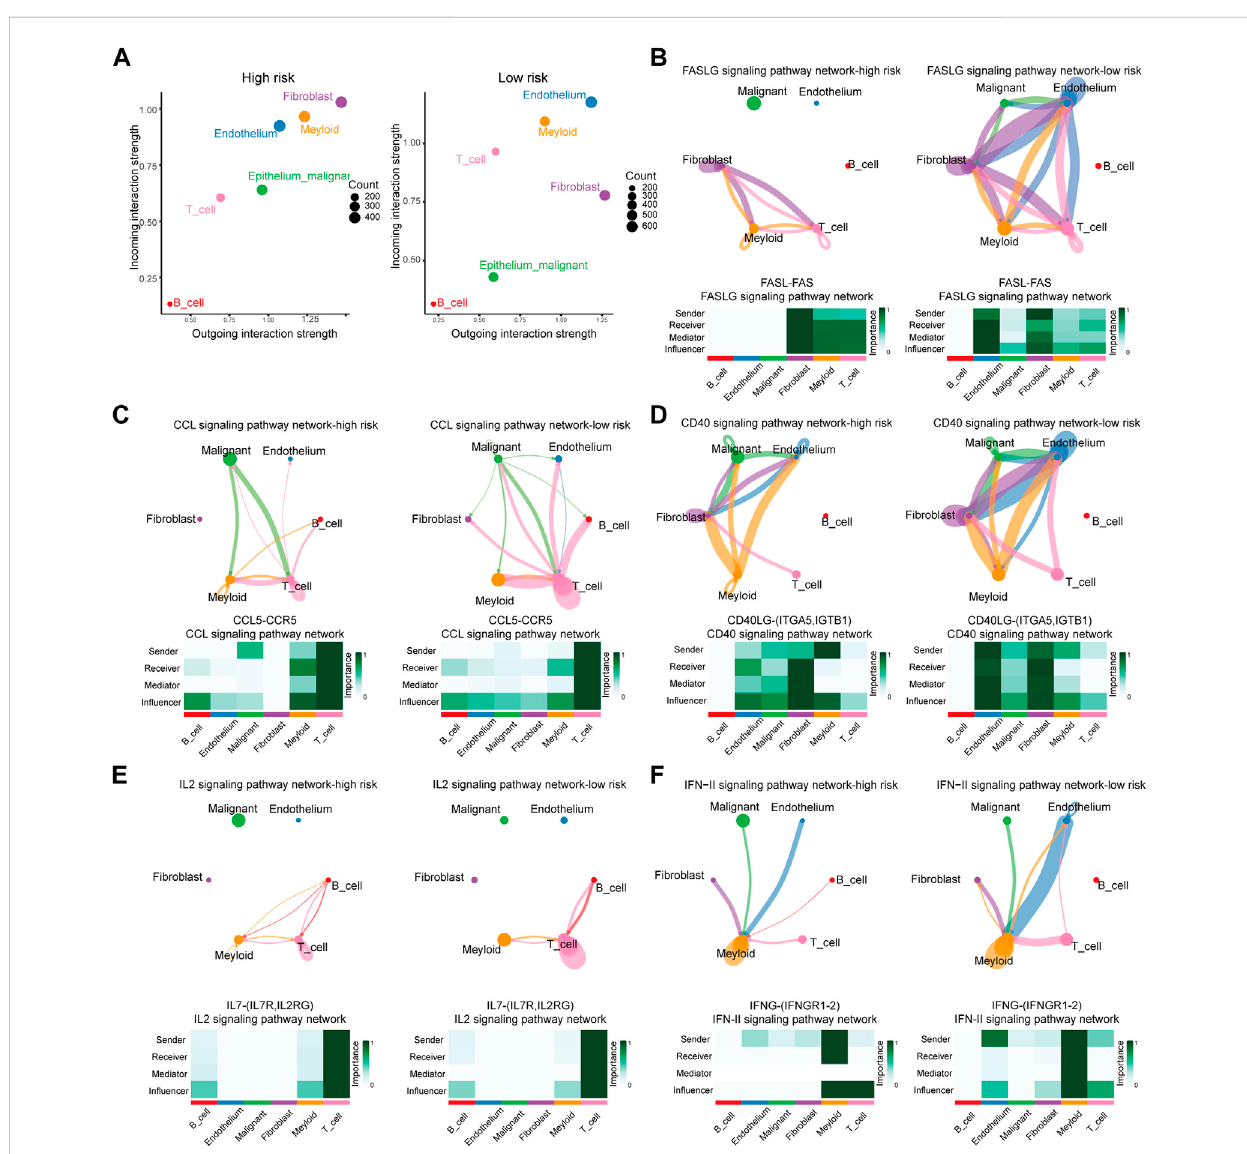
FIGURE 7 Differences of Ligand-Receptors in cell communication between high- and low-risk samples of single-cell RNA-Seq. (A) Dot graphs show how intensively each cell type communicates in high-risk and low-risk samples. (B) FASLG signaling network of high- and low-risk samples. (C) CCL signaling network of high- and low-risk samples. (D) CD40 signaling network of high- and low-risk samples. (E) IL2 signaling network of high- and low-risk samples. (F) IFN-II signaling network of high- and low-risk